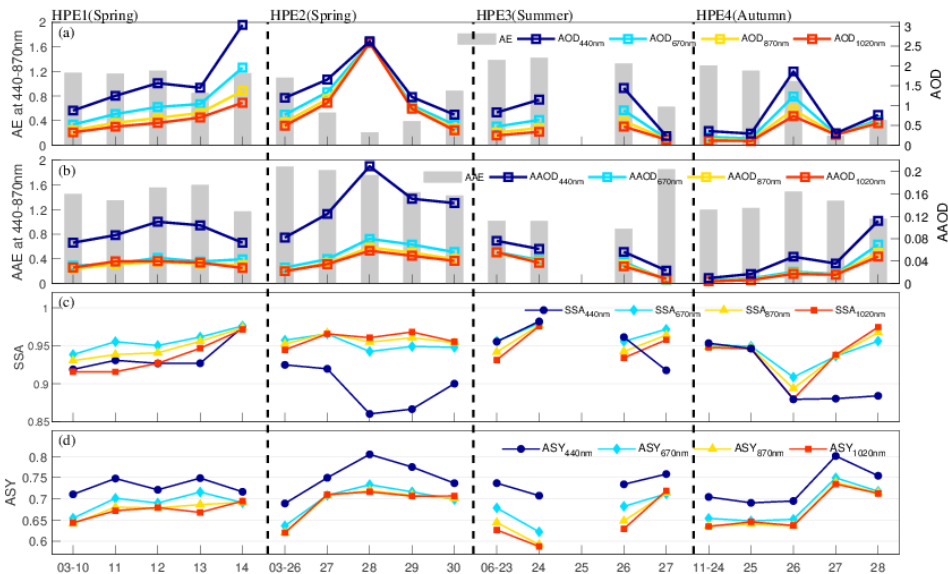
Figure 4. Daily variation in ( a ) AOD; ( b ) AAOD; ( c ) SSA; and ( d ) ASY at 440, 670, 870, and 1020 nm, as well as ( a ) AE and ( b ) AAE for the whole column, during four heavy pollution episodes (HPE1, 2, 3, and 4) in Beijing in 2018.